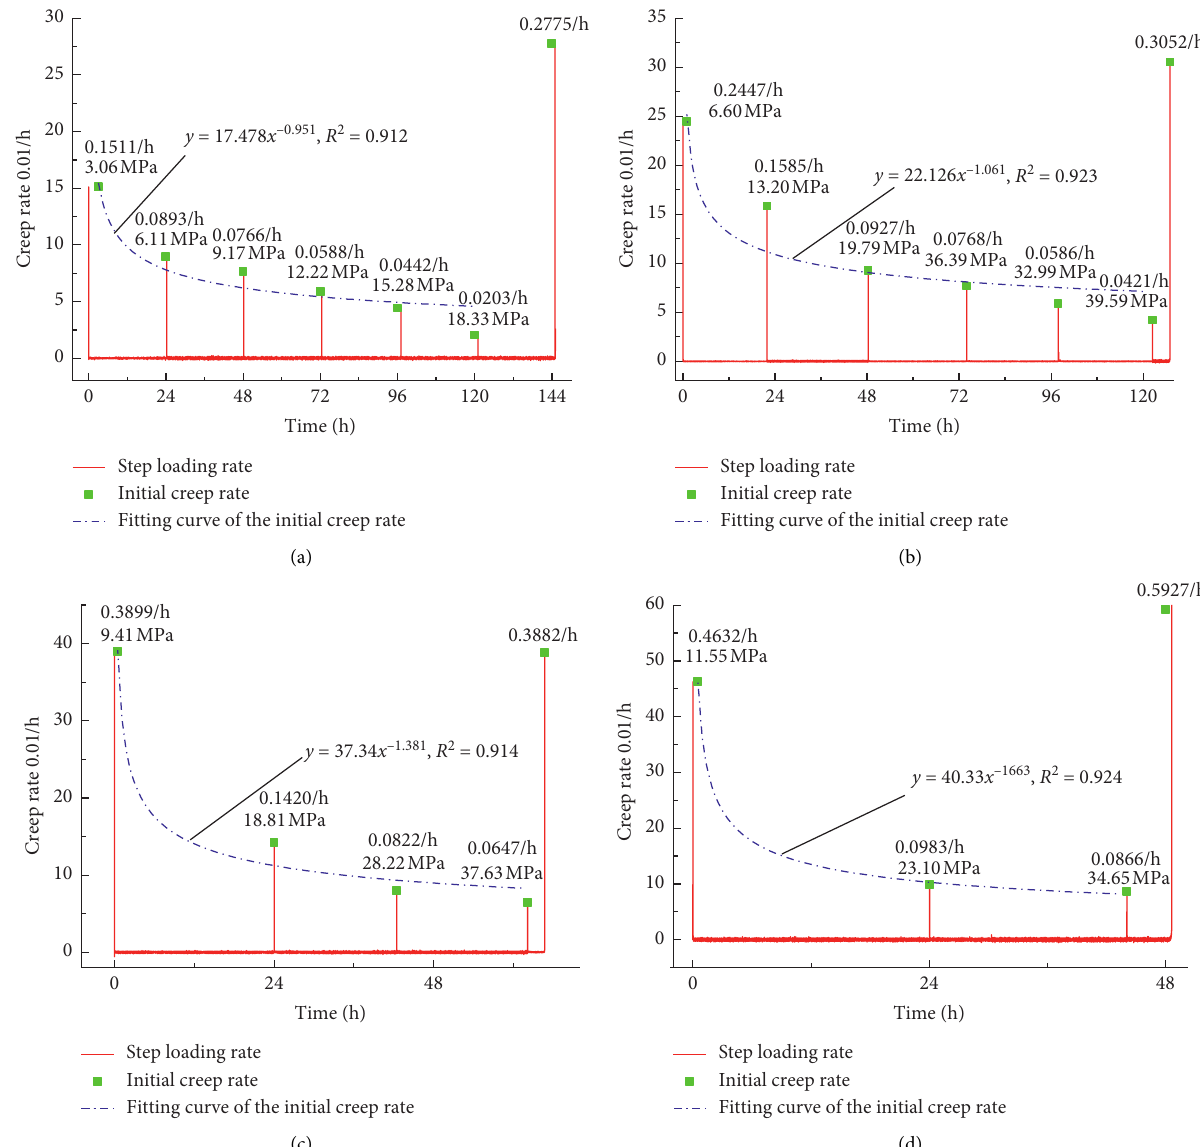
Figure 7: Fitting curves of step loading rate and initial creep rate of composite specimens under different confining pressures. (a) Confining pressure 0 MPa. (b) Confining pressure 7 MPa. (c) Confining pressure 15 MPa. (d) Confining pressure 22